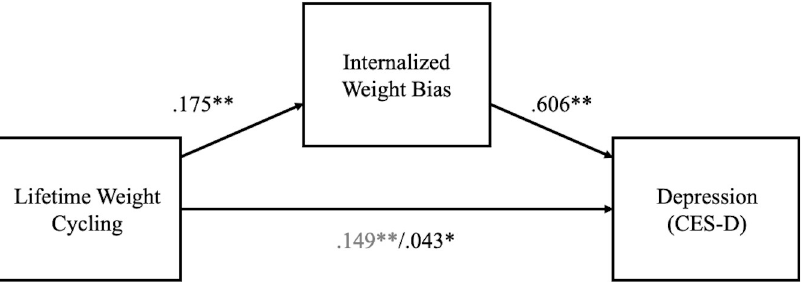
Fig 1. The relationship between weight cycling and depressive symptoms mediated by internalized weight stigma. Path weights are standardized regression weights. Total effect is printed in grey text. Mediation analysis included gender, age, education, income, and BMI as